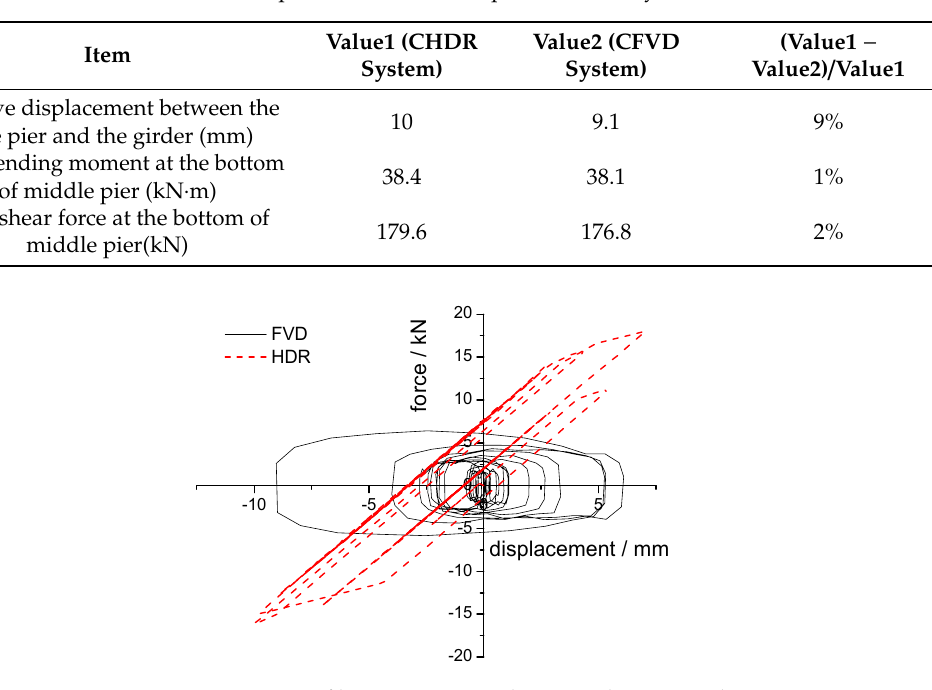
Figure 18. Comparison of hysteretic curves between the FVD and HDR. Table 5. Comparison of seismic responses of two systems.